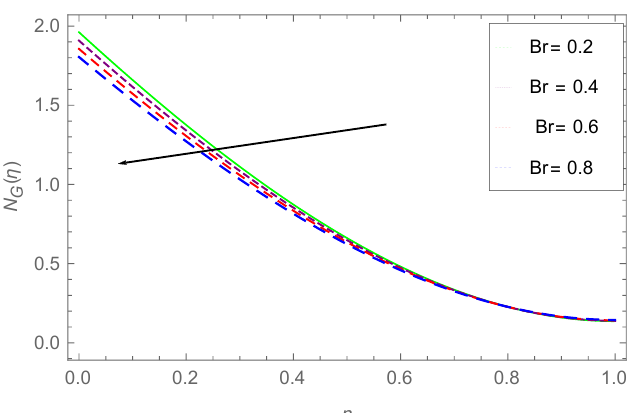
Figure 23. Variations in the function of entropy N G ( η ) for unlike values of Br , when M = 0.7, R e = 0.6, Rd = 0.8 and Pr = 1.5.